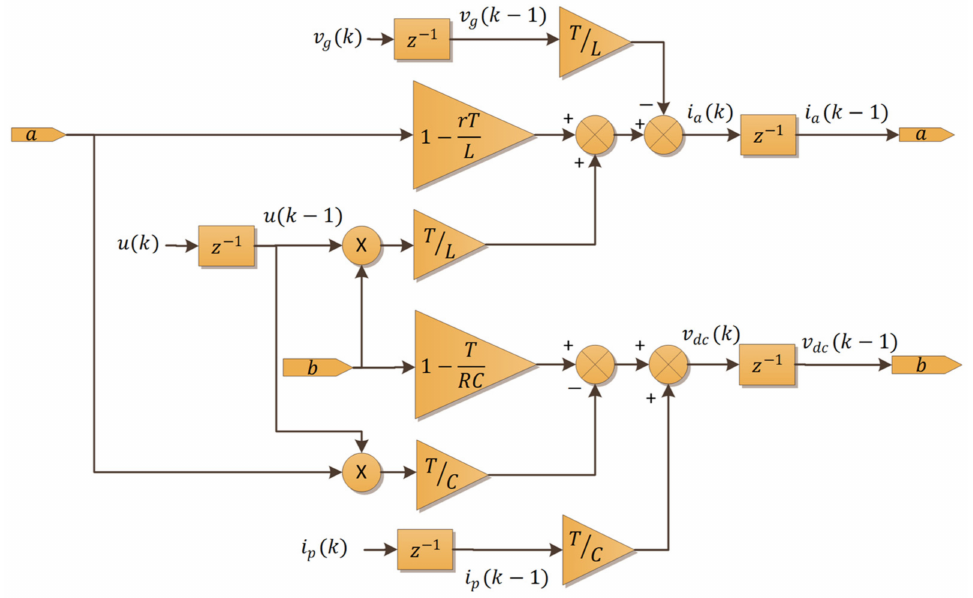
Figure 11. Implementation of the discrete H full bridge converter model.